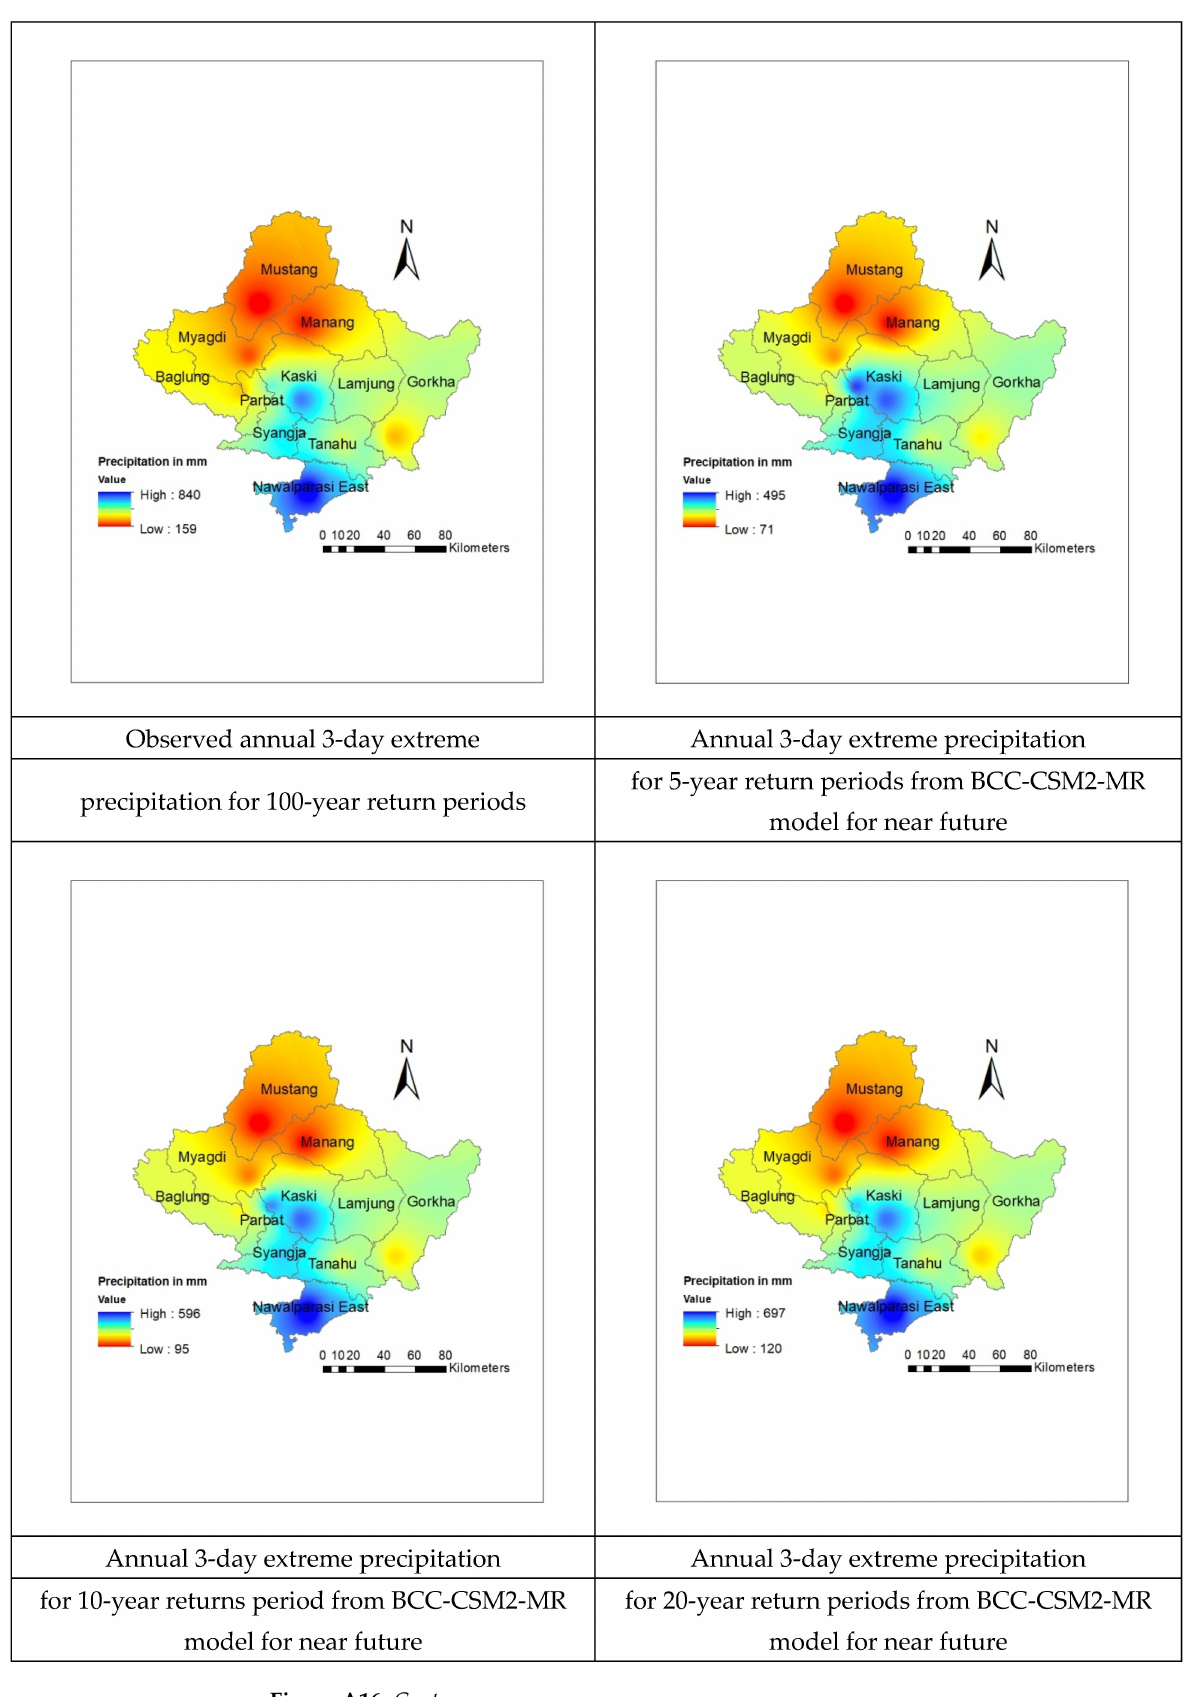
Figure A16. Cont